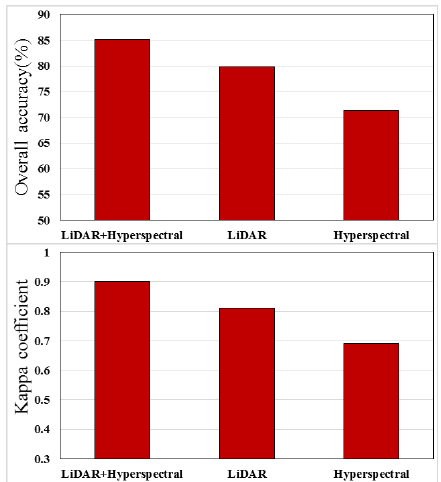
Figure 10. Accuracy assessment results of three different